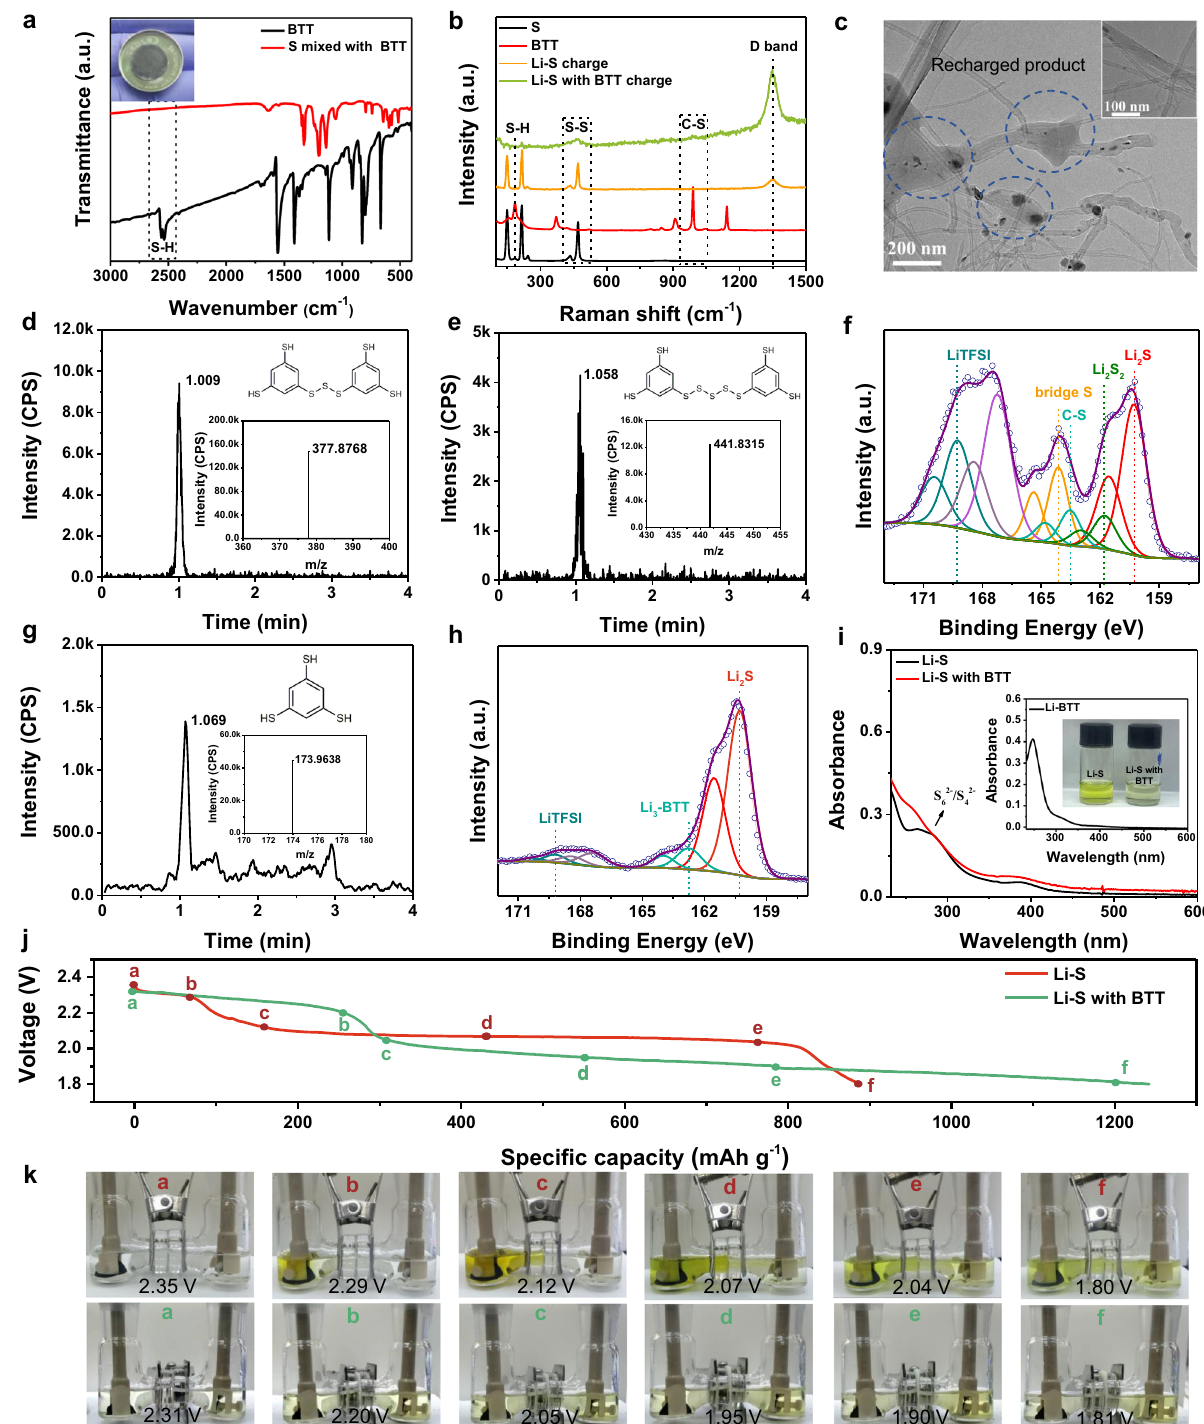
Fig. 4 Characterization for the redox process in the cell. a FTIR spectra of raw material BTT and sulfur cathode with 20 μ L of 0.15 M BTT electrolyte. b Raman spectra of raw material BTT, elemental S, and the recharged products of the Li-S batteries with and without BTT. c TEM image of recharged cathode for Li – S cell with BTT electrolyte (inset image is the blank carbon paper). d , e XIC of the recharged products for BTT cell, (inset: the corresponding MS and structure). f XPS data for the recharged cathode after 5 cycles at 0.05C rate for the BTT cell. g XIC of the discharged product for BTT cell (inset: the corresponding MS and structure). h XPS spectrum of the discharged cathode after 5 cycles for BTT cell. i UV – vis absorption spectra of the solutions acquired by the Li – S cells with BTT and blank electrolyte discharge to 2.1 V. j First discharge curves for Li – S visible cells with BTT and blank electrolyte. k Photographs for the two types of cells in j at different discharge